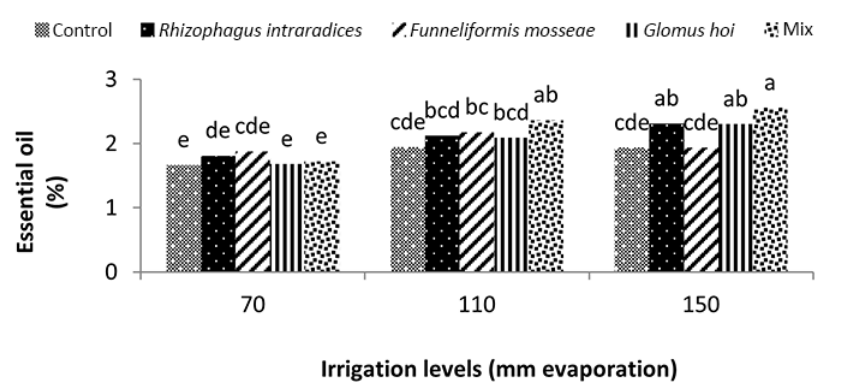
Figure 10 Effect of arbuscular mycorrhization and irrigation levels on essential oil percentage of peppermint.